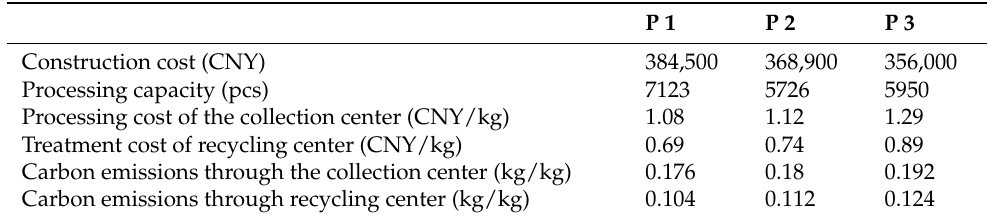
Table A9. Details of various costs, treatment capacities, and unit carbon emissions of waste treatment center